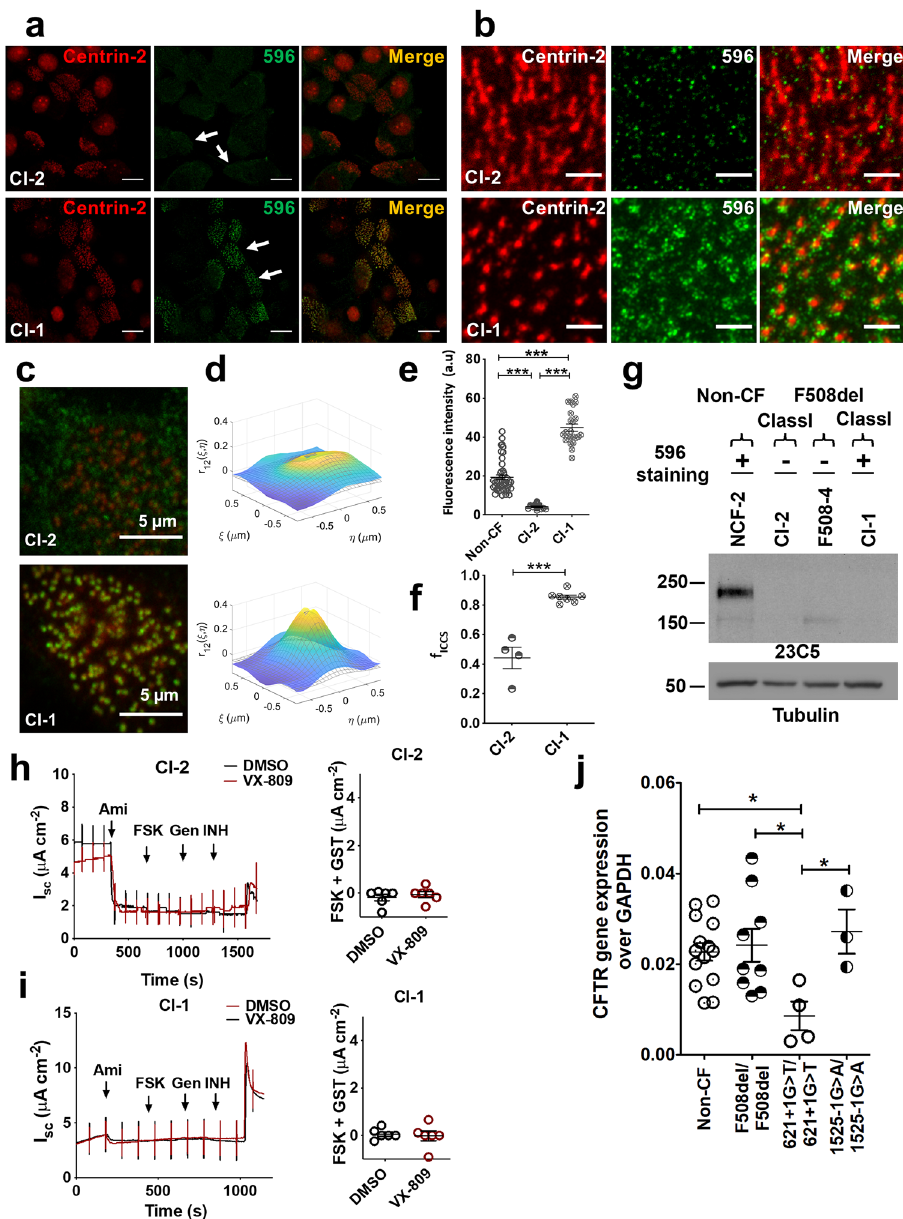
Figure 5. Apical 596 immunofluorescence in ciliated cells that are homozygous for Class I CFTR mutations. ( a ) Confocal images of well differentiated pHBE cells from patients homozygous for 1525-1G > A (CI-2, top row) or 621 + 1G > T (CI-1, bottom row). ( b ) Representative STED images of the apical surface of CI-2 (top row) or CI-1 (bottom row) cells. ( c ) Confocal images of the apical surface of CI-2 (top row) and CI-1 (bottom row) cells immunostained with 596 and centrin-2 antibodies used for ICCS analysis. ( d ) Examples of spatial cross-correlation functions calculated via ICCS analysis from sub-regions (64 × 64 pixels) of the ciliated region images used to calculate colocalization values for CI-2 (top) and CI-1 (bottom) . ( e ) Fluorescence intensity of 596 immunostaining at the apical pole of CI-2 and CI-1 cells (mean ± SE, n = 12–23, *** p < 0.0001, one-way ANOVA). Intensity was normalized to the excitation power. ( f ) Colocalized fraction f ICCS extracted from ICCS analysis (mean ± SD, n = 3–6, *** p = 5 × 10 –5 , t-test). ( g ) Immunoblot of well differentiated HBE cells from non-CF, class I mutations, or F508del, probed for CFTR using the mAb23C5. Note that CI-1 cells are immunostained by 596 but do not have detectable CFTR protein ( h , I , these images are from one blot). Representative short-circuit current recordings and after pretreatment with DMSO (black) or VX-809 (1 µM, red) for 24 h. Cells were exposed to amiloride (Ami; 100 µM), forskolin (FSK; 10 µM), genistein (Gen; 50 µM) and CFTR inh -172 (INH; 10 µM). The histogram shows stimulations induced by FSK + Gen. ( j ) CFTR mRNA levels in well differentiated HBE cells from non-CF donors and patients homozygous for F508del and a Class I mutation. Data were obtained by qPCR using primers that amplify sequence near the 5’ end of the transcripts and results were normalized to GAPDH (mean ± SE, n = 3–14; non-CF vs 621 + 1G > T/621 + 1G > T, * p = 0.0360; F508del/F508del vs 621 + 1G > T/621 + 1G > T, * p = 0.02727; 1525-1G > A/1525-1G > A vs 621 + 1G > T/621 + 1G > T, * p = 0.0413; one-way ANOVA). Individual points represent independent